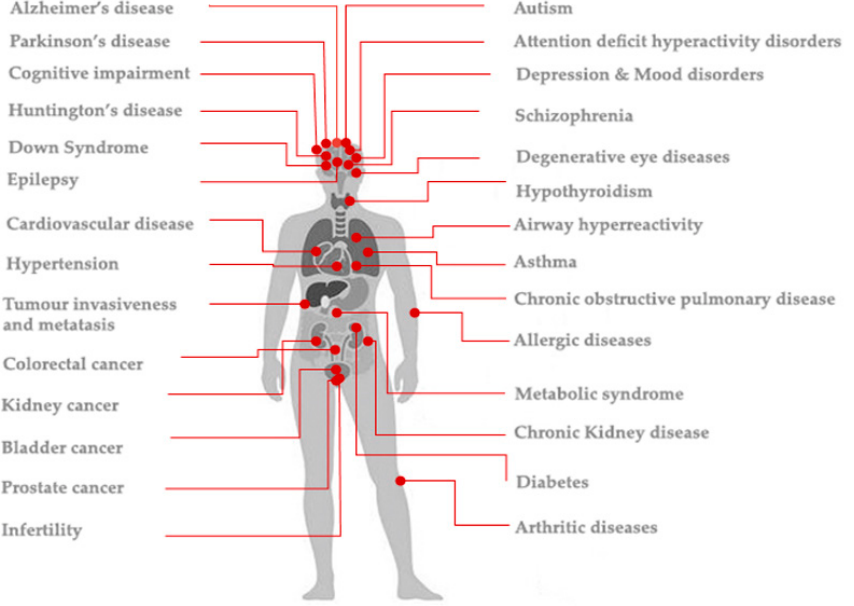
Figure 1. Pathophysiological conditions and neurological disorders associated with loss of Na + , K + -ATPase activity.